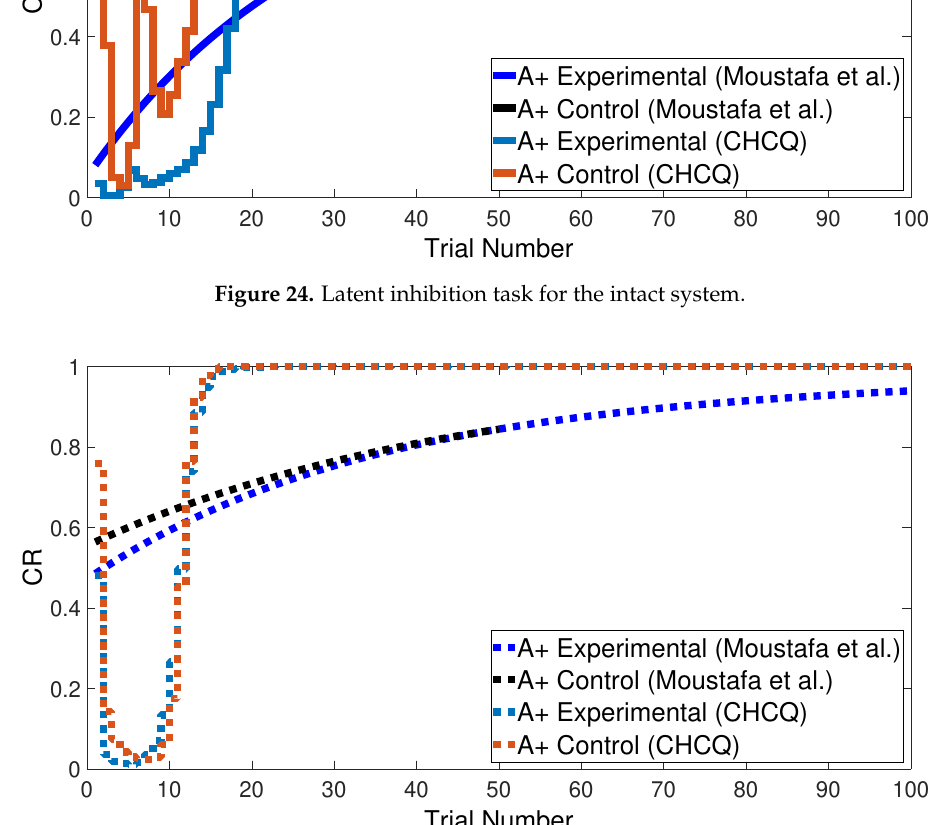
Figure 25. Latent inhibition task for the lesioned